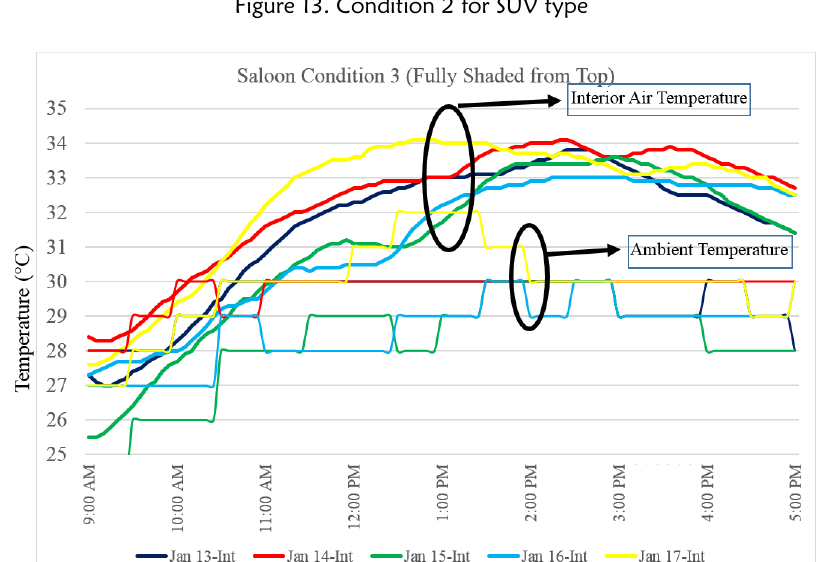
Figure 13. Condition 2 for SUV type